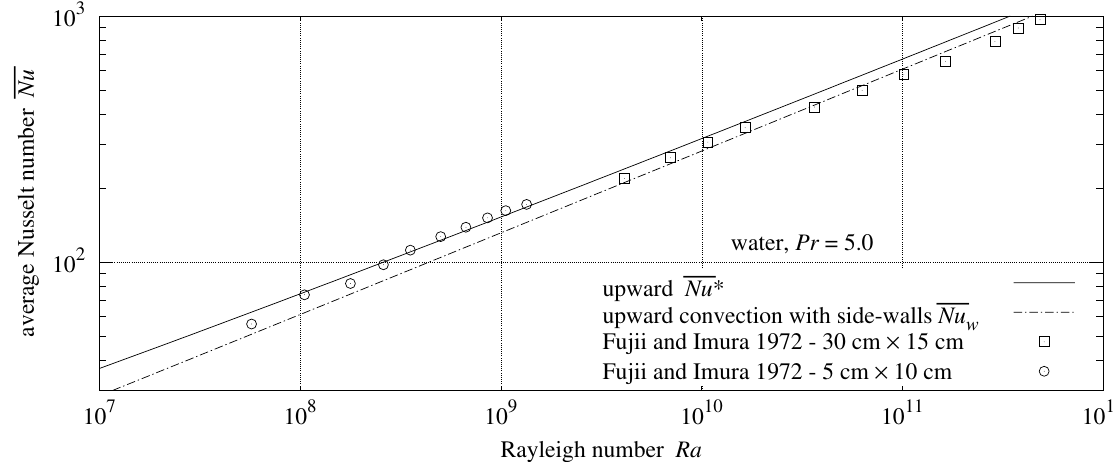
Figure 9. Upward-Facing Fujii and Imura plates. Table 10. Upward-Facing Fujii and Imura plates.